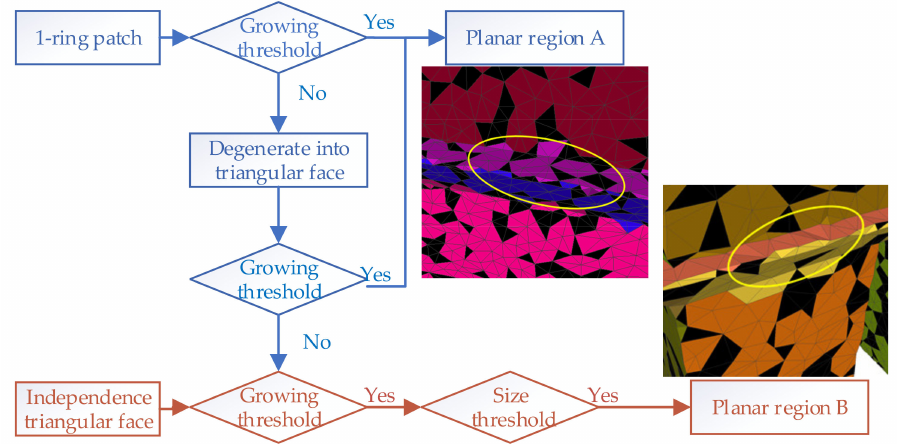
Figure 5. Two-step strategy of region growth. As shown in the area of the golden ellipse in planar region A and planar region B, in addition to complete patches, the degenerate triangles and inde- pendent triangles at the boundary are accurately segmented into the corresponding plane region (different colors represent different plane regions). In general, the scattered black faces that are not labeled as any plane region are too negligible to influence the extraction of the importance of plane